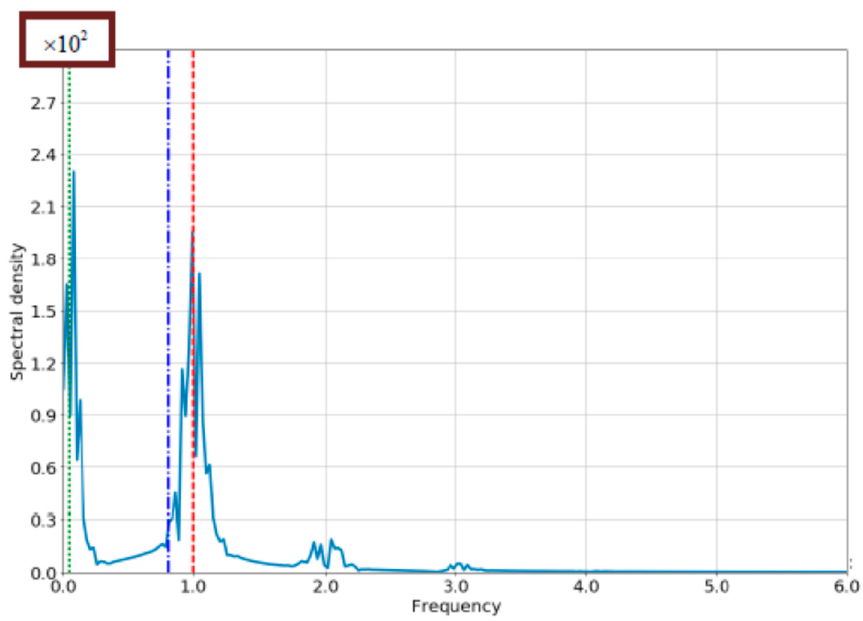
Figure 6. Frequency spectrum of the density of the tunneling current with RO and BO in the separated frequency ranges. t a = t b = 0.04. All other parameters are identical to Figure 5.